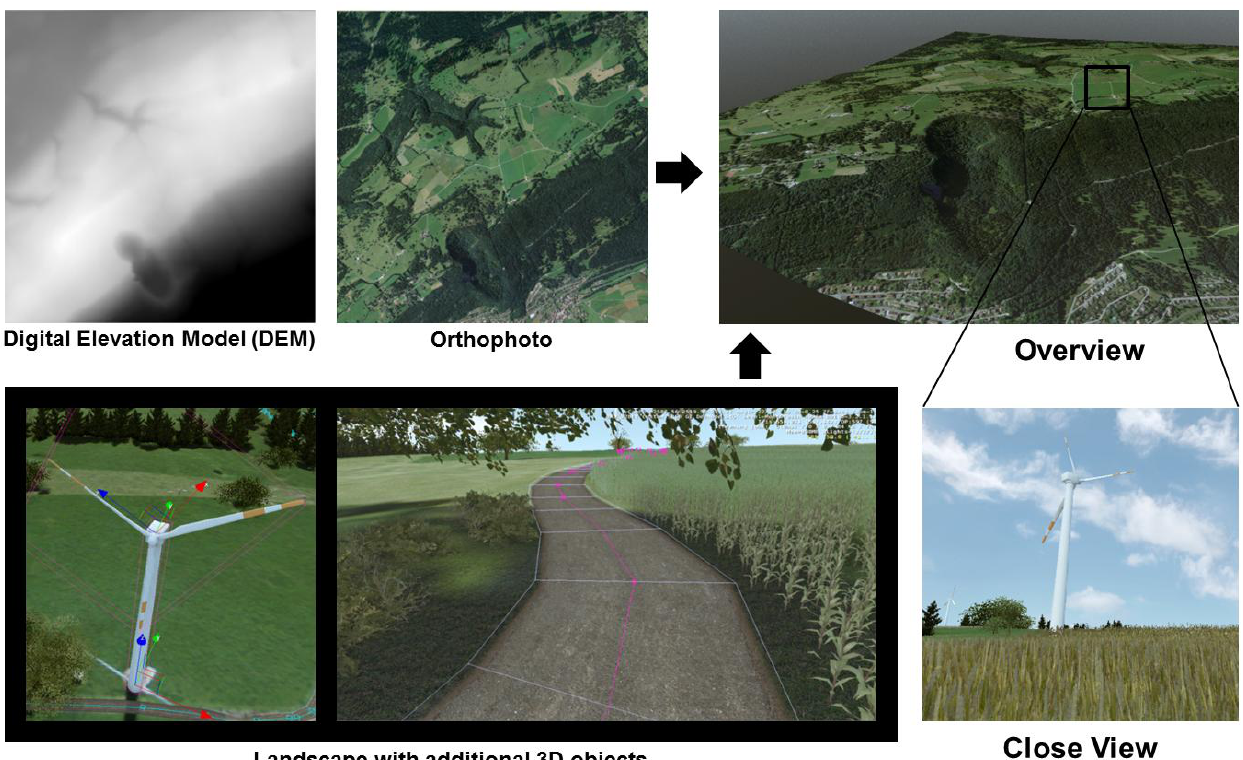
Figure 1. Visual simulation process of the wind farm at Mont Crosin.